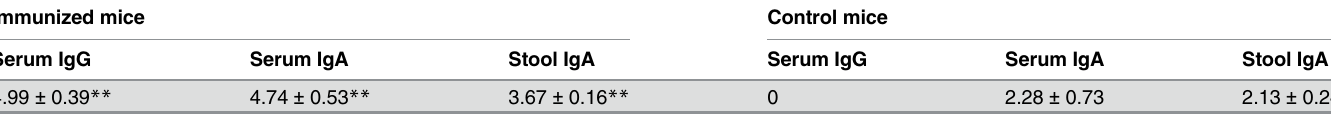
Table 1. Serum and stool antibody levels * to dmLT in immunized and control